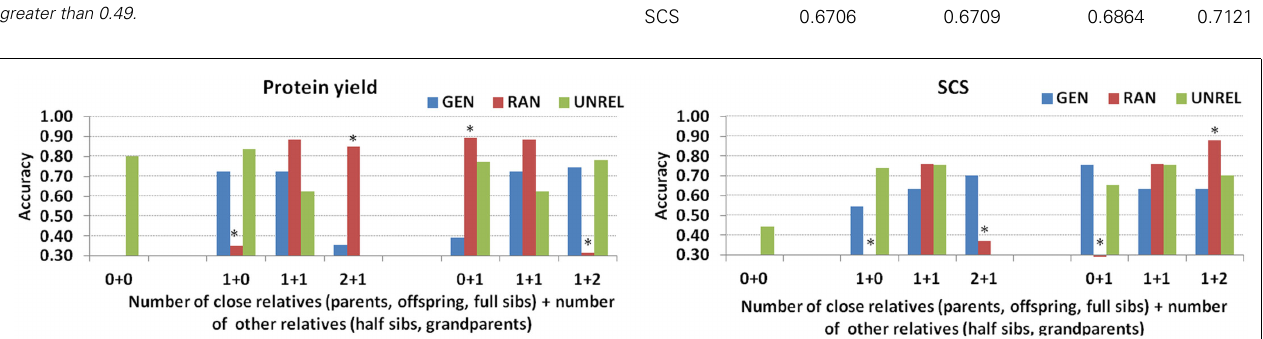
FIGURE 2 |Accuracy of predictions for protein yield and somatic cell score (SCS) depending on the number and type of relatives in the training set for the generational (GEN), random (RAN), and theA-matrix decomposition (UNREL) designs (* indicates correlation obtained from less than 10